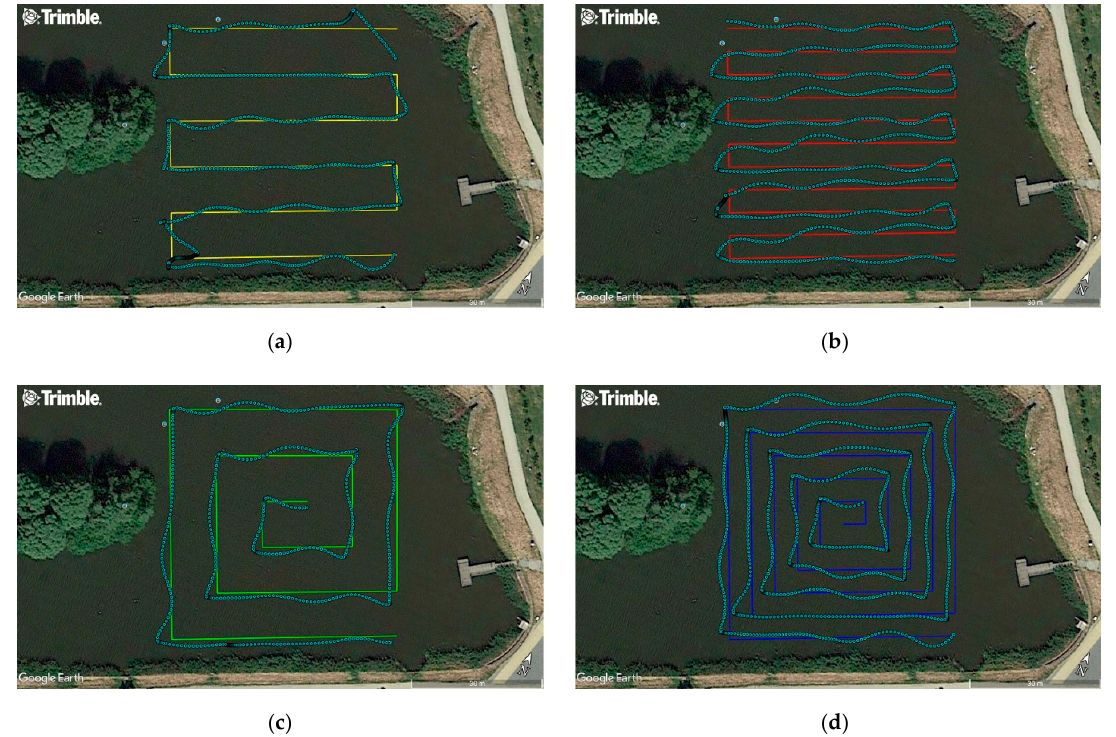
Figure 7. Sounding profiles designed in two variants: parallel ( a , b ) and spiral ( c , d ), along with the actual plotted USV route. Measurement points were recorded by a geodetic GNSS receiver (sky-blue colour).